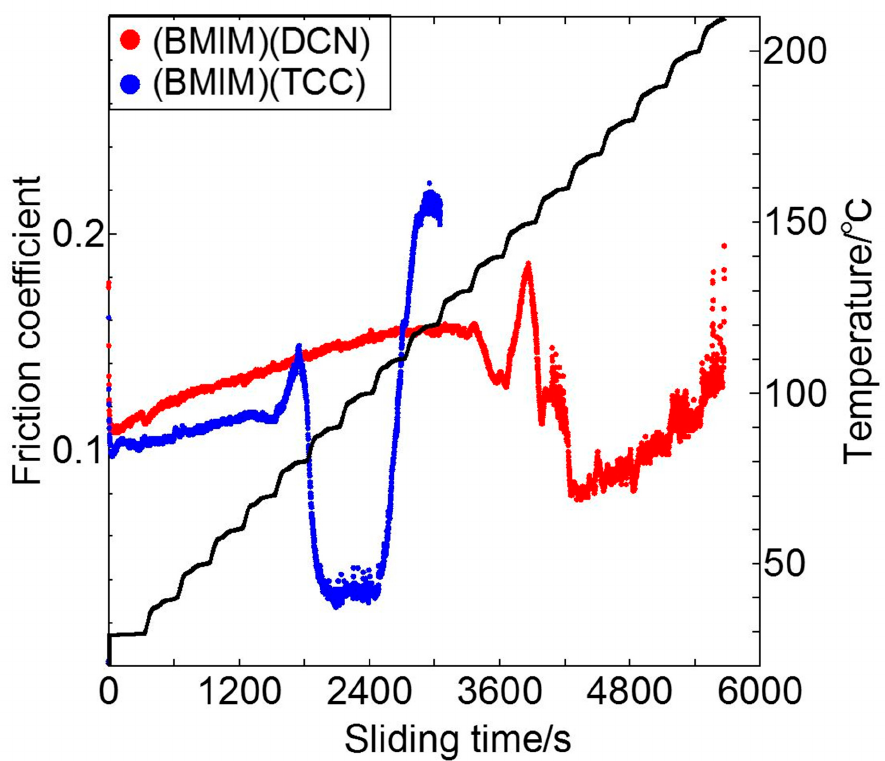
Figure 1. Friction behaviors of (BMIM)(DCN) and (BMIM)(TCC) at elevated temperatures. Coatings 2020 , 10 , x FOR PEER REVIEW